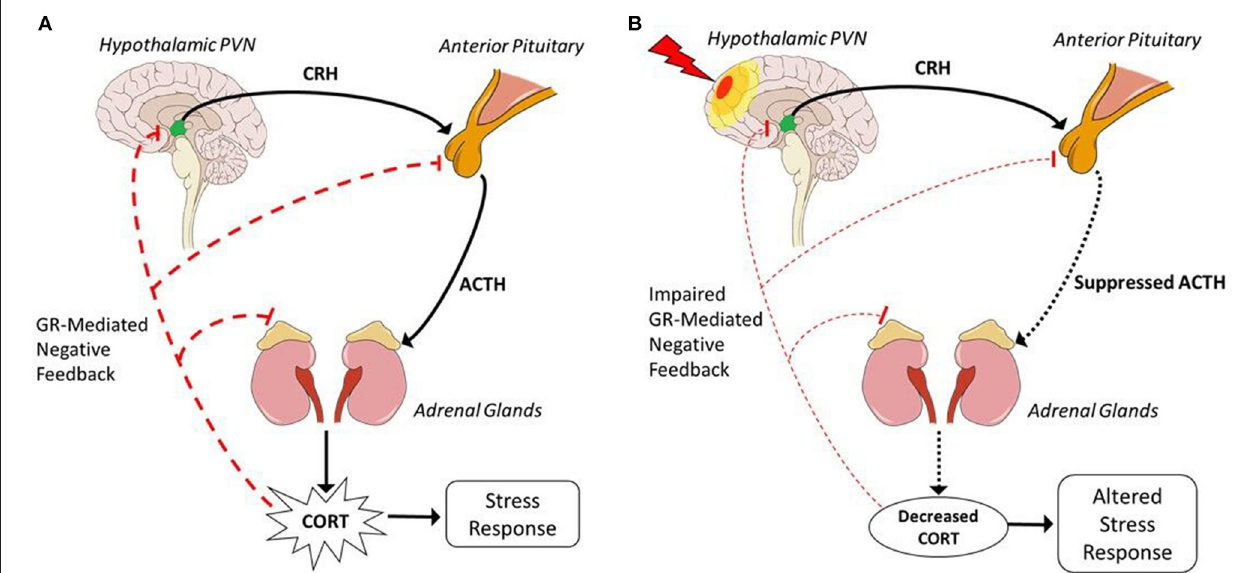
FIGURE 1 | Hypothalamic-pituitary-adrenal axis before and after TBI. (A) In response to stressors, excitatory neuronal inputs activate the HPA axis and are transformed into hormonal communication, represented by solid black lines, to produce a physiological stress response. Activation via excitatory neuronal inputs to the hypothalamic PVN releases CRH and AVP via the median eminence into hypothalamic hypophyseal portal circuitry to the anterior pituitary. CRH induces corticotropes in the anterior pituitary to stimulate production of ACTH. ACTH is released into the blood and travels to the adrenal glands, superior to the kidneys. In the